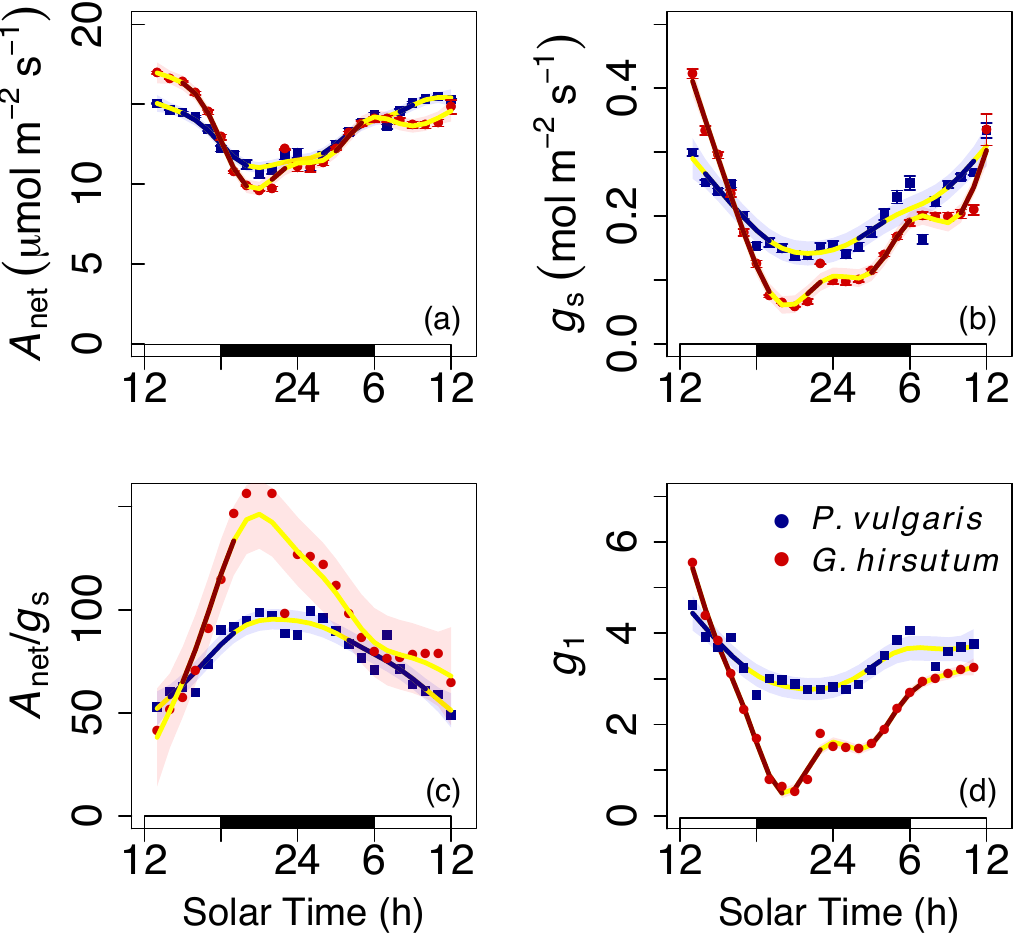
Figure 1. Circadian oscillation in gas exchange. The dots (with small SE bars hidden) indicate hourly averages of ( a ) assimilation ( A net ), ( b ) stomatal conductance ( g s ), ( c ) the ratio between the two ( A net / g s ), and ( d ) a parameter proportional to the marginal water cost of carbon gain ( g 1 ). Measurements were conducted under constant environmental conditions (see Figure 2). The white and black rectangles at the base indicate the subjective day (when it would have been daytime during entrainment) and subjective night, respectively, under constant conditions. Lines (and shaded error intervals) indicate the prediction (and SE) of Generalized Additive Model (GAM) fitting separately for each species (some lines may overlap), and portions which are not yellow indicate significant temporal